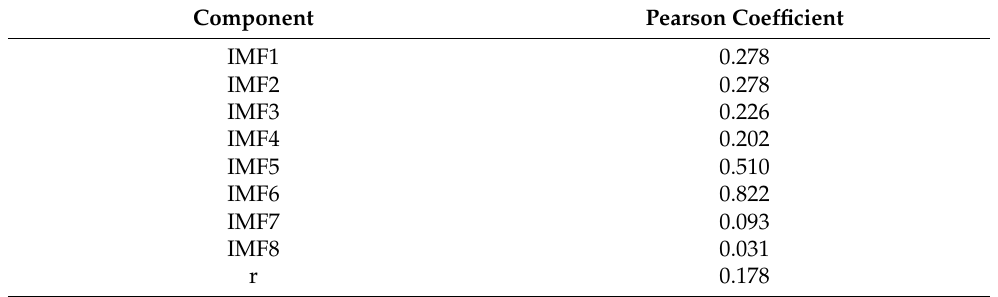
Table 2. Pearson coefficient.